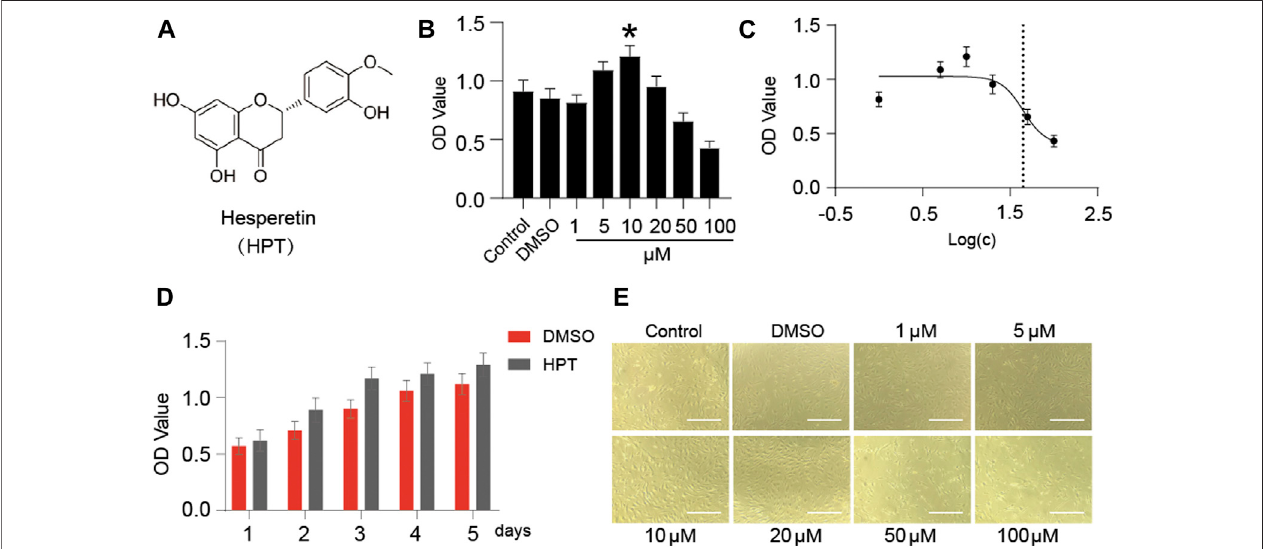
FIGURE1| CytotoxicityofHPT-treated chondrocytes. (A) ThemolecularstructureofHPT. (B) Differentconcentrations(1,5,10,20,50,and100 μ M)ofHPT were cultured for 48 h, with * p < 0.05 as a signi fi cant difference. (C) The IC50 of HPT to chondrocytes, and the concentration is transferred to Log(c). (D) HPT treated 10 µM and controlled the cell proliferation curve for 5 days. (E) Photographs of cells cultured with different concentrations (1, 5, 10, 20, 50, and 100 μ M) of HPT for 48 h.